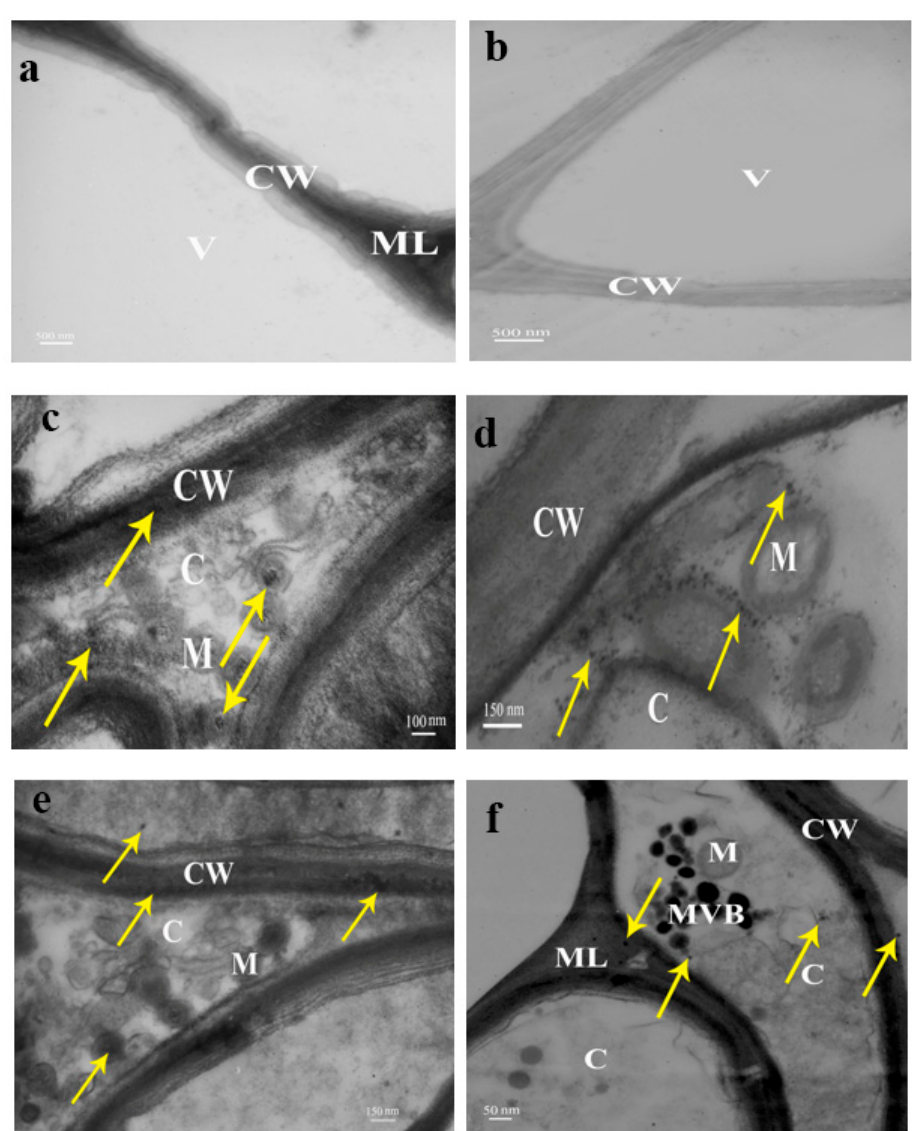
Figure 3. TEM images of L. minor root cells. ( a , b ) Control comprising cell wall (CW), vacuole (V), and middle lamella (ML). ( c – f ) Cells of treated plants with 80 mg L − 1 CdSe NPs comprising CW, middle lamella, cytoplasm (C), multiple vesicular bodies (MVB), mitochondria (M), and arrows define CdSe NPs agglomerations.